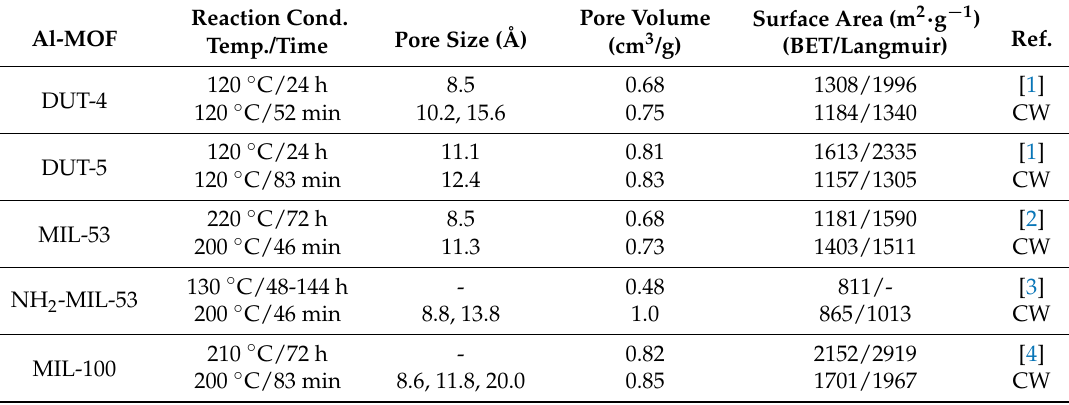
Table 2. Comparison of porosity data our MW-synthesized MOFs with their corresponding literature. Al-MOF Reaction Cond. Temp./Time